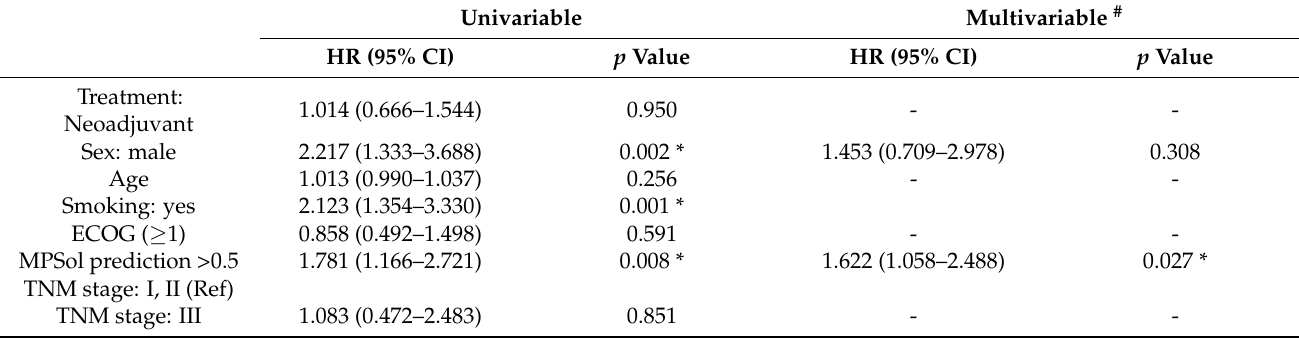
Table 1. Cox Regression Analysis for Overall Survival in Validation Set. Univariable Multivariable